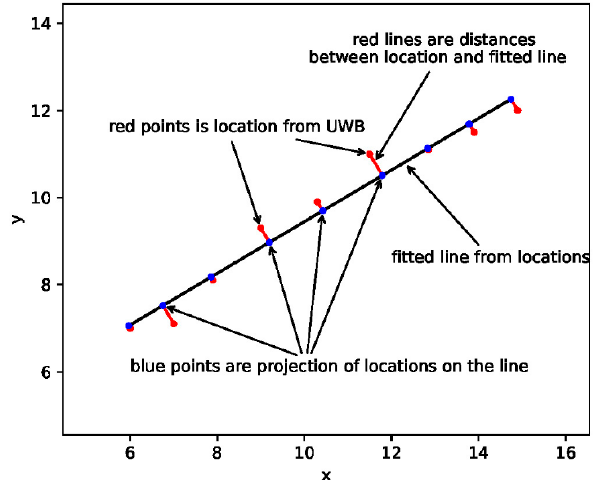
Figure 5. Trajectory estimation from UWB-based positioning results.